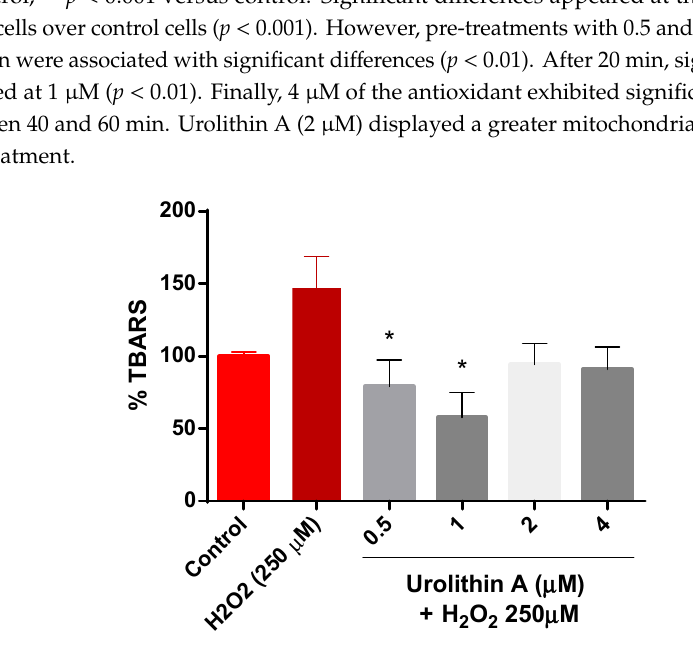
Figure 4. Thiobarbituric acid reactive species (TBARS) formation in Neuro-2a cells. Note: * p < 0.05 versus H 2 O 2 .